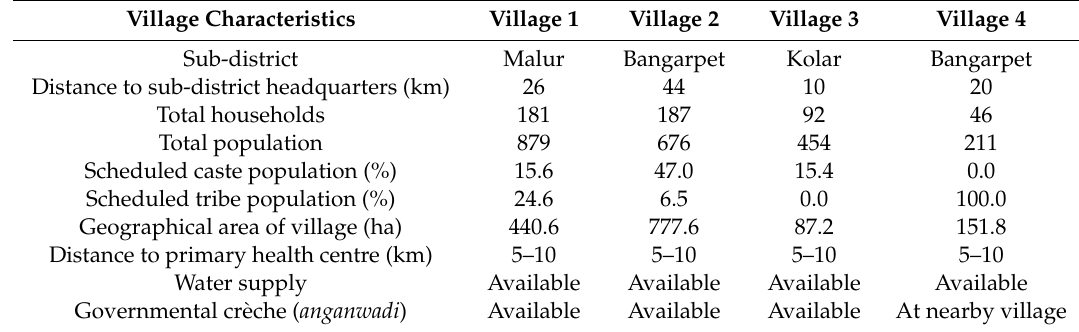
Table 1. Characteristics of the four study villages in Kolar district, southern India where watershed development projects were implemented (taken from